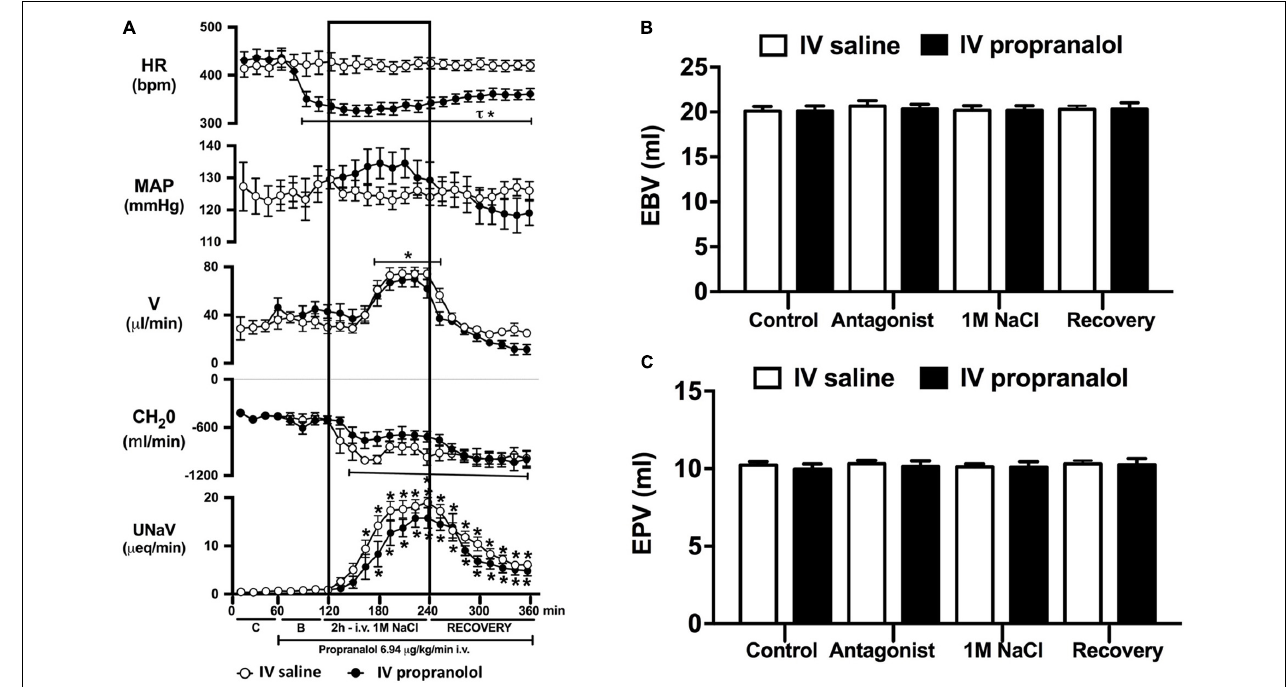
FIGURE 5 | Effect of acute i.v. propranolol-mediated β -adrenoceptor antagonism on the cardiovascular and renal responses to an acute 1M NaCl infusion (A) Cardiovascular and renal responses, (B) Estimated blood volume (ml), and (C) Estimated plasma volume (ml) during a 1-h control isotonic saline infusion (20 µ l/min), a 1-h baseline propranolol infusion (6.94 µ g kg − 1 min − 1 in isotonic saline; 20 µ l/min), a 2-h propranolol and 1M NaCl infusion (20 µ l/min) and a 2-h recovery period of propranolol in isotonic saline infusion (20 µ l/min) in intact conscious male Sprague Dawley rats. HR = heart rate (bpm), MAP = mean arterial pressure (mmHg), V = urinary flow rate ( µ L/min), CH 2 O = free water clearance, UNaV = urinary sodium excretion ( µ eq/min). Data are presented as mean ± SEM, N = 6/group. * p < 0.05 vs. group baseline value in last 15-min of the control saline infusion. τ p < 0.05 vs. respective isotonic saline group infusion value. Please note the same isotonic saline group data is presented in Figures 4 , 5 for